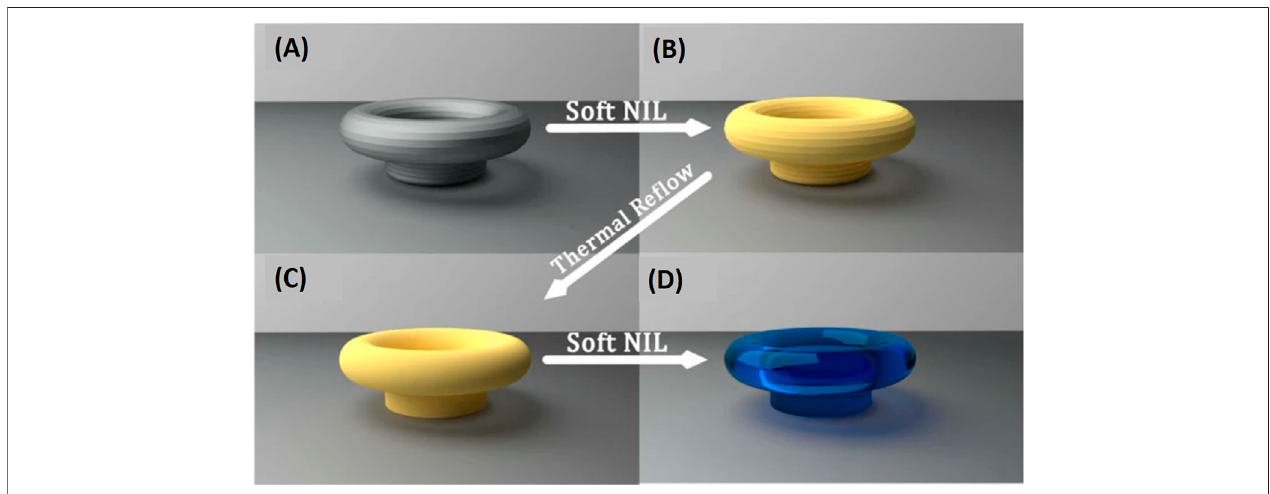
FIGURE7| Dual-step soft nanolithography. (A) Master devicefabricated using DLW madeofcrosslinked SU-8(gray). (B) FirstsoftNIL step -Replication of the master device into non-crosslinked SU-8 (yellow). (C) Re fl ow replica from non-crosslinked SU-8 (Yellow). (D) Second soft NIL step – replication of the re fl owed resonator into sol-gel (blue). Reproduces from Bar-on et al. (2018), open access article distributed under the terms of the Creative Commons CC BY license.